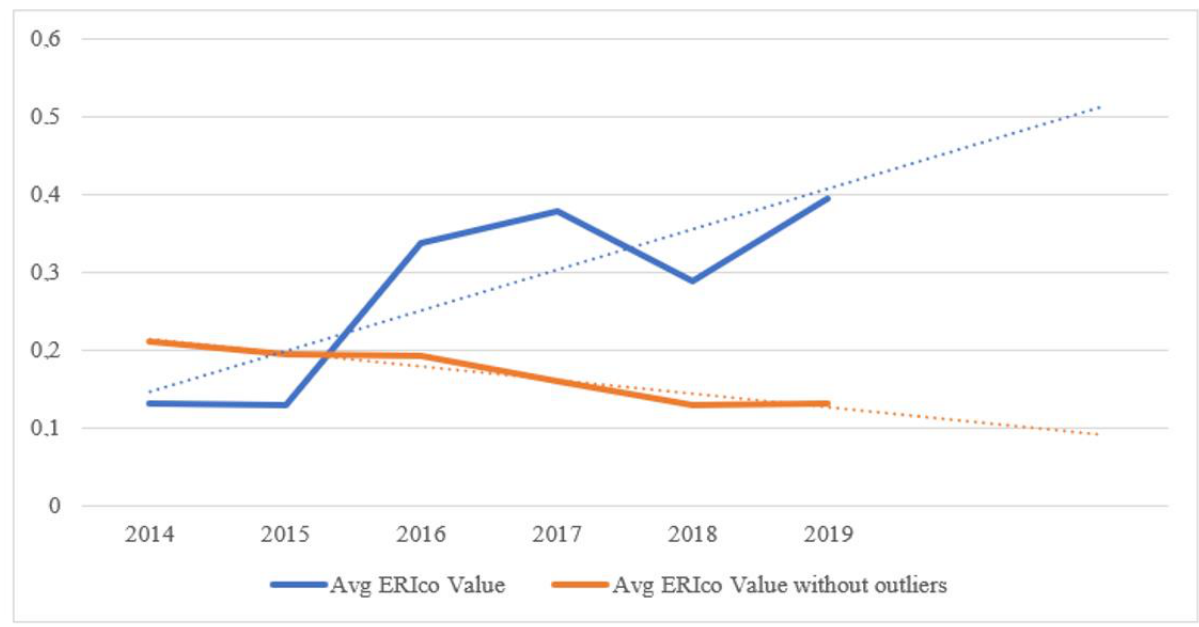
Table 2. Average ERI CO values in the Slovak Republic in the period 2014 – 2019.